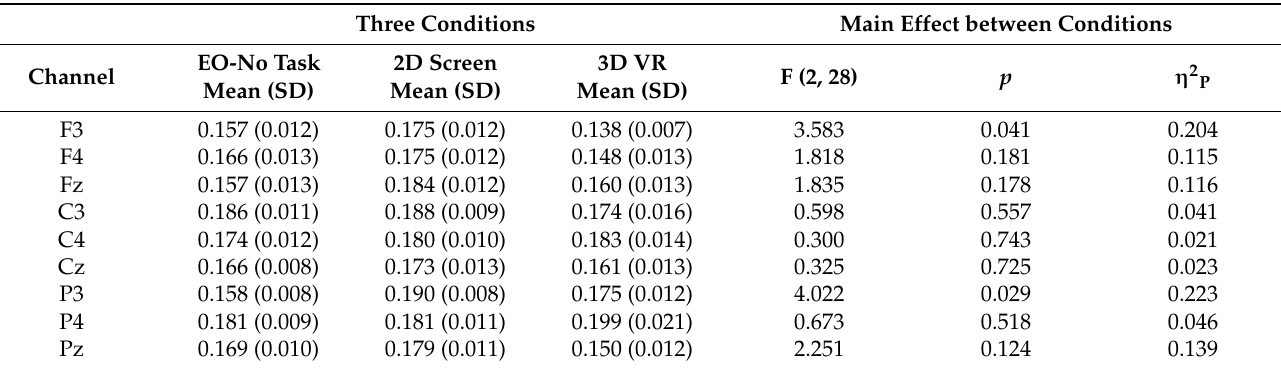
Table 5. Relative EEG beta power for the three conditions EO-no task, 2D screen and 3D